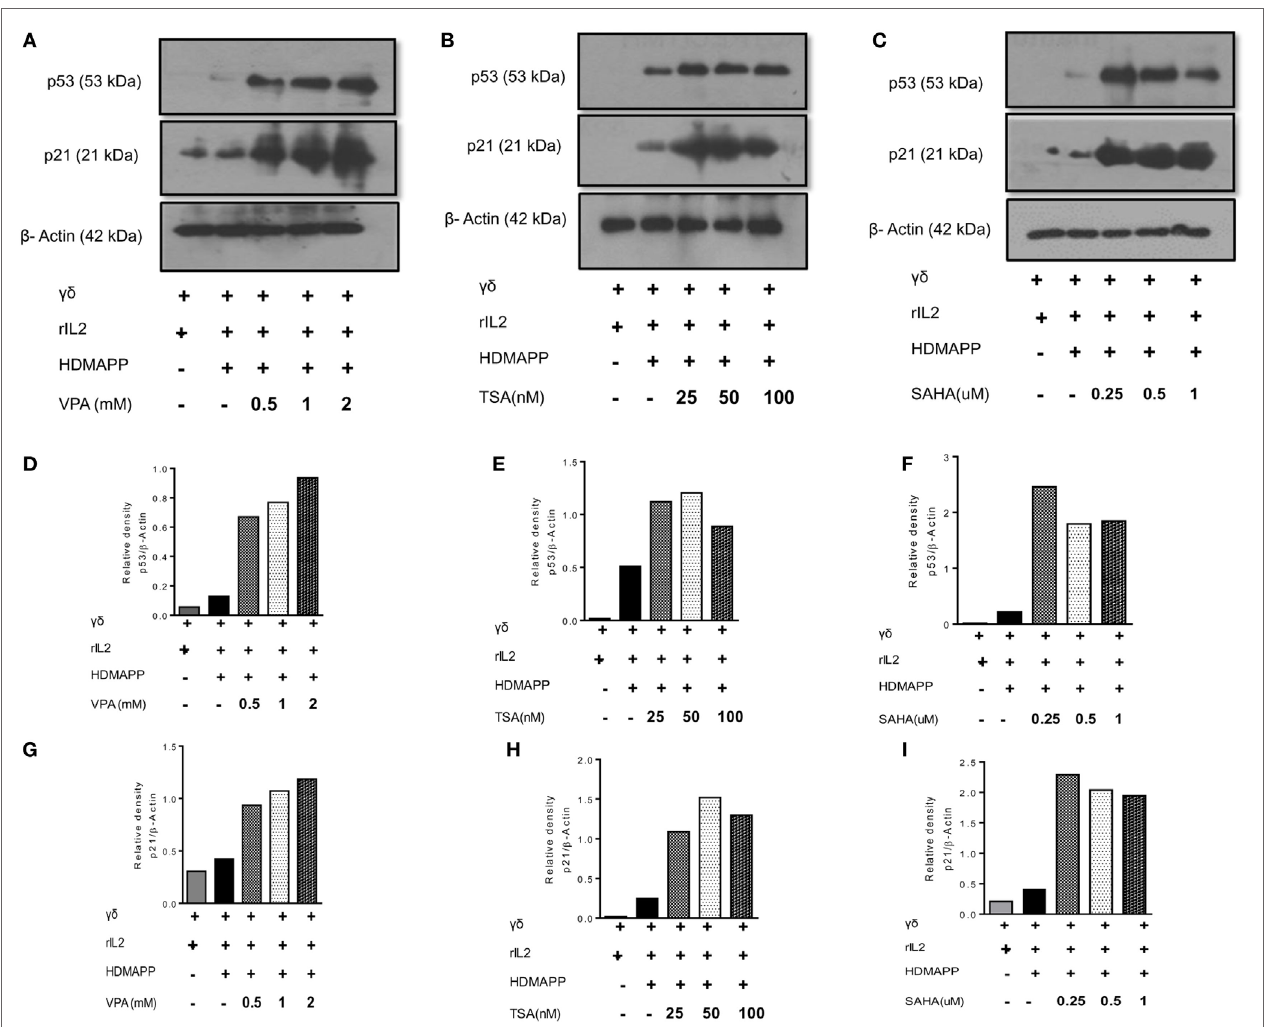
FigUre 1 | Histone deacetylases (HDAC) inhibitors increase the expression of cell cycle checkpoint proteins p53 and p21. Protein expression of p53 and p21 by γδ T cells upon treatment with (a) sodium valproate (VPA), (B) Trichostatin-A (TSA), and (c) suberoylanilidehydroxamic acid (SAHA) as detected by western blotting. Cell lysates of γδ T cells, stimulated with HDMAPP after treatment with HDAC inhibitors at different concentrations for 72 h were prepared and p53, p21 proteins were detected. β -actin was used as loading control. Densitometry quantification of p53 (D–F) and p21 (g–i) expression in γδ T cells upon treatment with VPA, TSA, and SAHA, relative to β